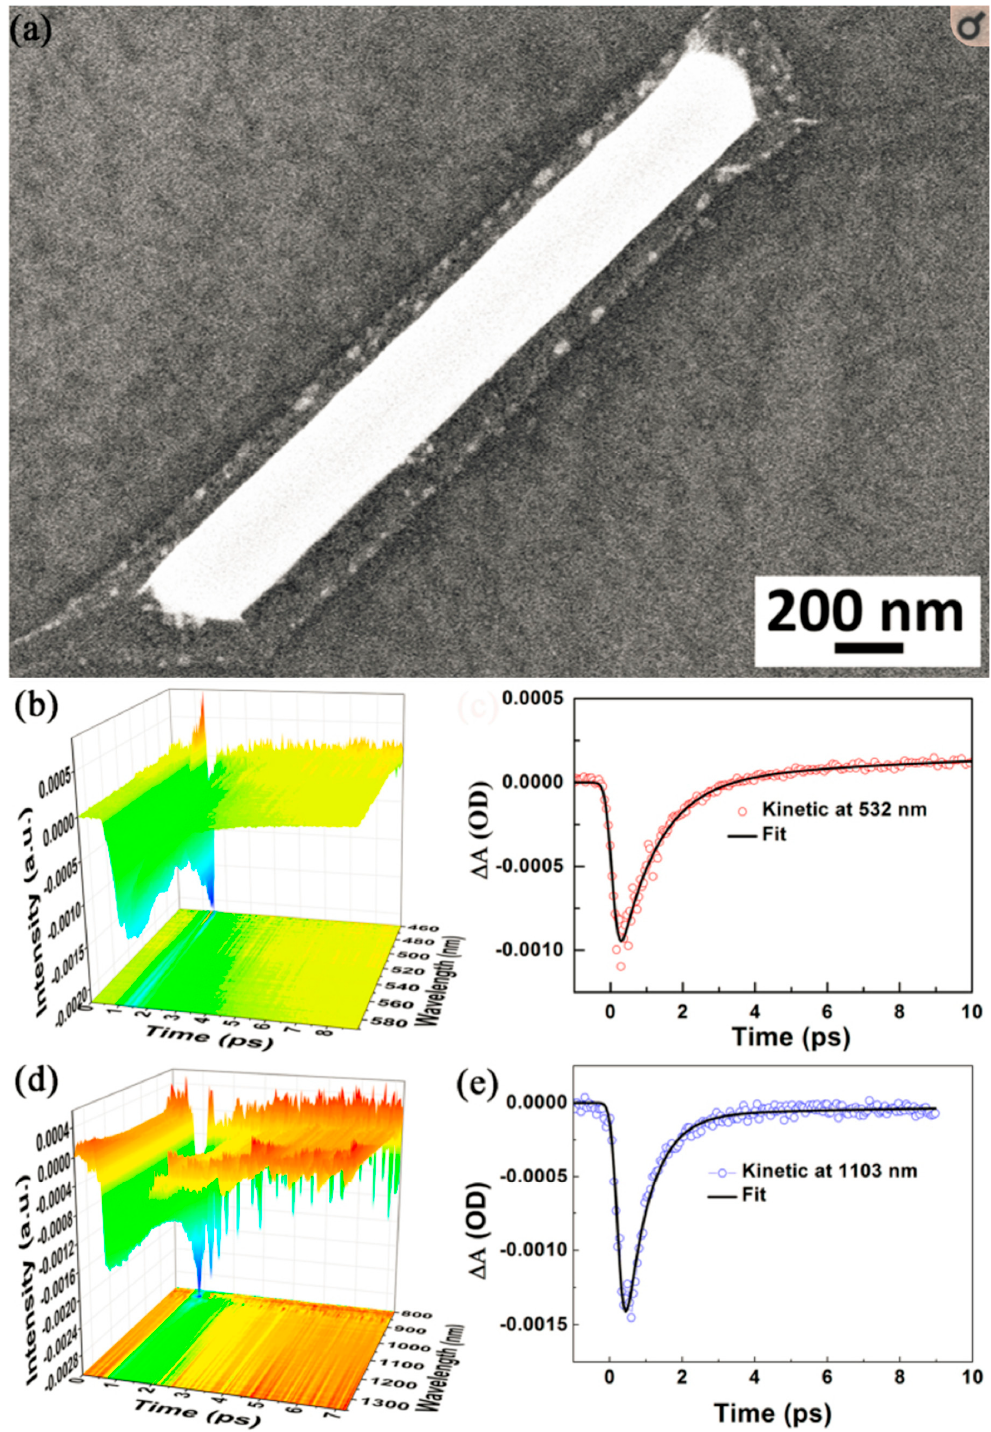
Figure 3. ( a ) The SEM image of Ag NW–graphene hybrid system. ( b ) The corresponding ultrafast pump-probe transient absorption spectroscopy excited by 400 nm, and ( c ) fitted at 532 nm. ( d ) The corresponding ultrafast pump-probe transient absorption spectroscopy excited in NIR region, and ( e ) fitted at 1103 nm [52].